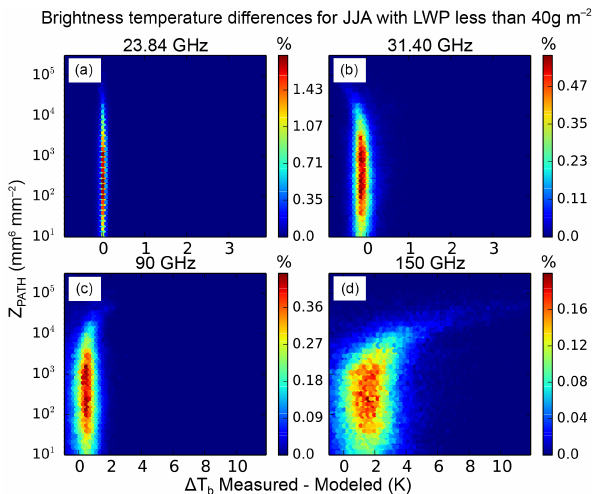
Figure 2. Brightness temperature differences between observations minus the modeled gas and liquid contributions in the 23.84, 31.40, 90, and 150GHz channels as a function of Z PATH for LWP less than 40gm 2 . The count histogram is binned logarithmically in Z PATH and linearly in (cid:49)T b , shown as percentage of total observation count per bin. The 150GHz channel shows an enhanced BT difference with respect to Z PATH (d) , while the 90GHz has a slight enhanced BT, the 31GHz exhibits a negative dependence, and the 23.84GHz is channel